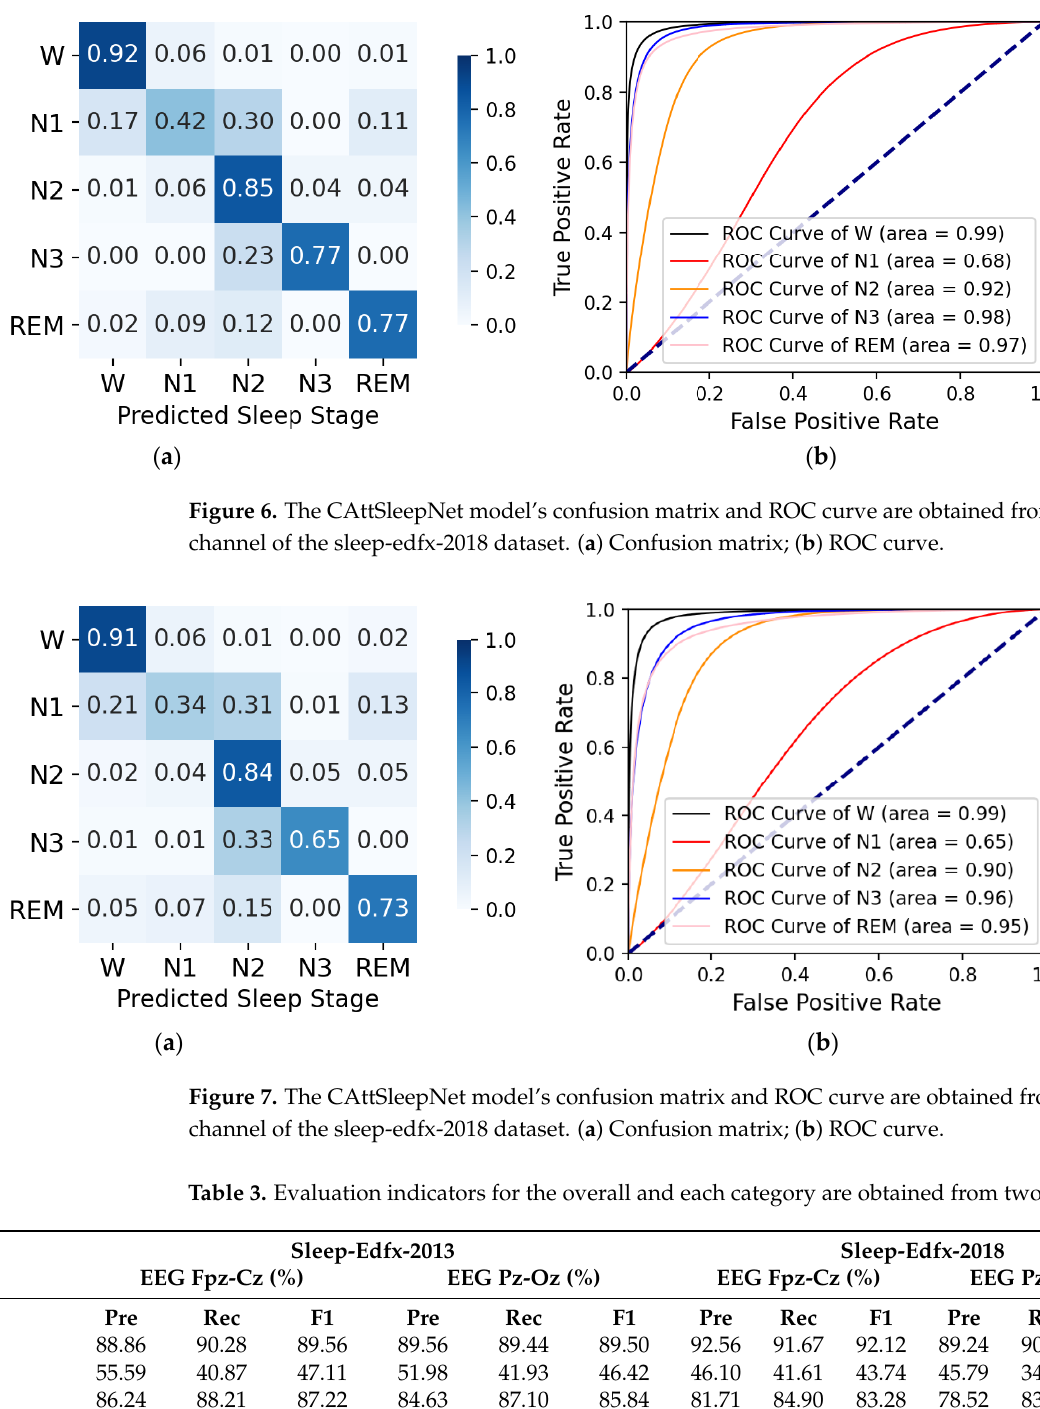
channel of the sleep-edfx-2013 dataset. ( a ) Confusion matrix; ( b ) ROC curve.